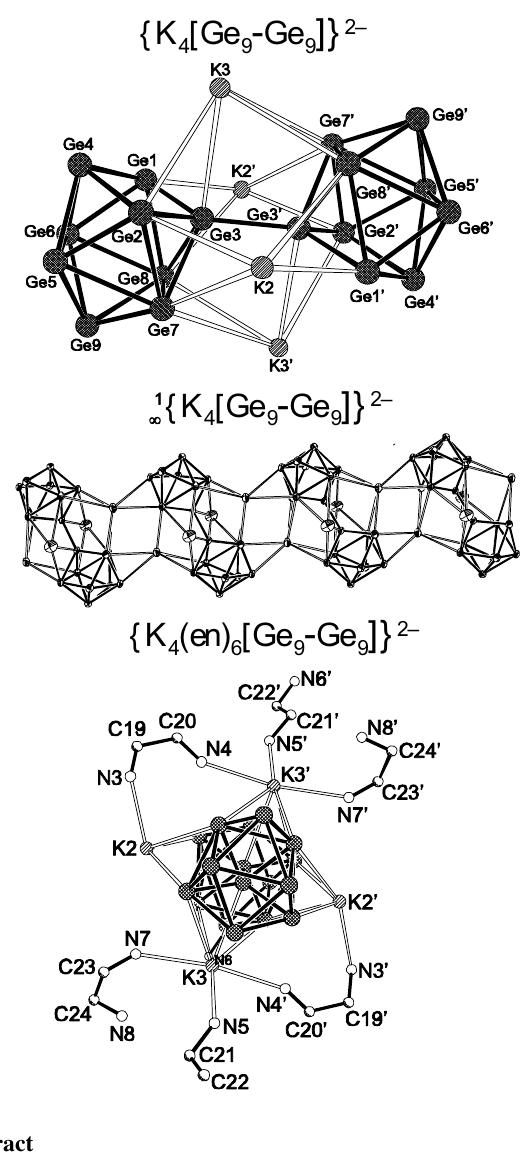
wR ref (F 2 ) = 0.192, T = 150